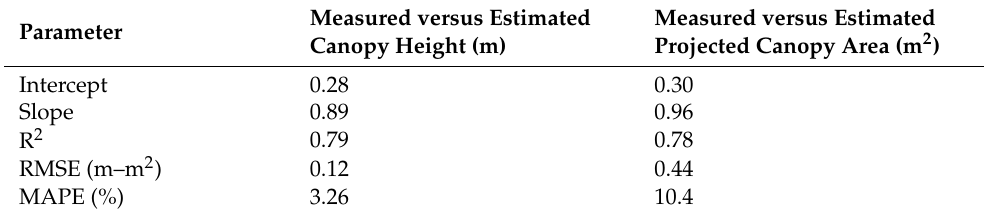
Table 1. Comparison between ground measured and UAV-estimated projected canopy area (m 2 ) and canopy height (m). Measurements were carried out on olive trees of cultivar Koroneiki, Biancolilla and Calatina (15 trees per cultivar) before